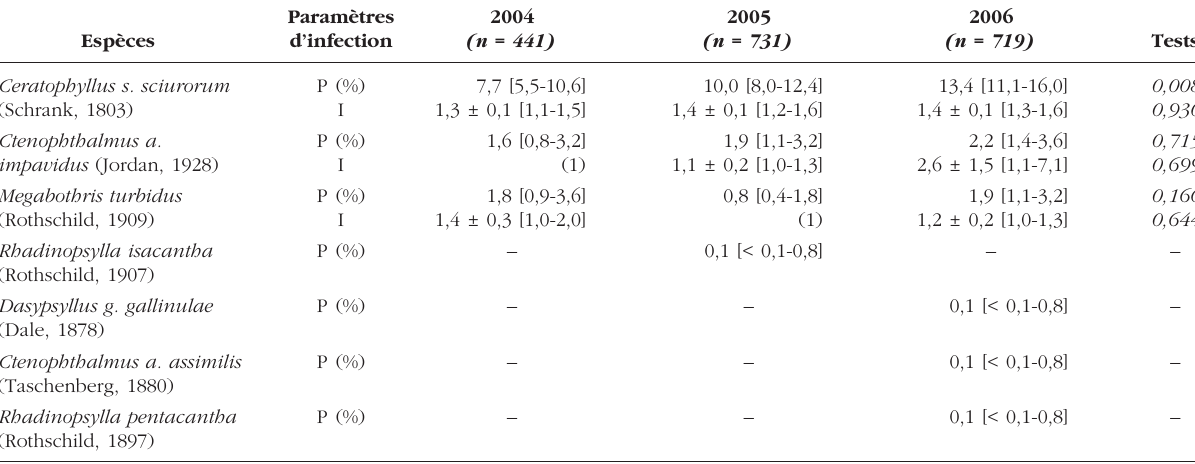
Tableau II. – Prévalence (P, et intervalle de confiance à 95 %) et intensité moyenne (I, et intervalle de confiance à 95 %) des espèces de puces collectées sur les tamias de Sibérie capturés entre mars 2004 et novembre 2006 en Forêt de Sénart. Test exact de Fisher pour les prévalences, test-t “bootstrapé” pour les intensités.